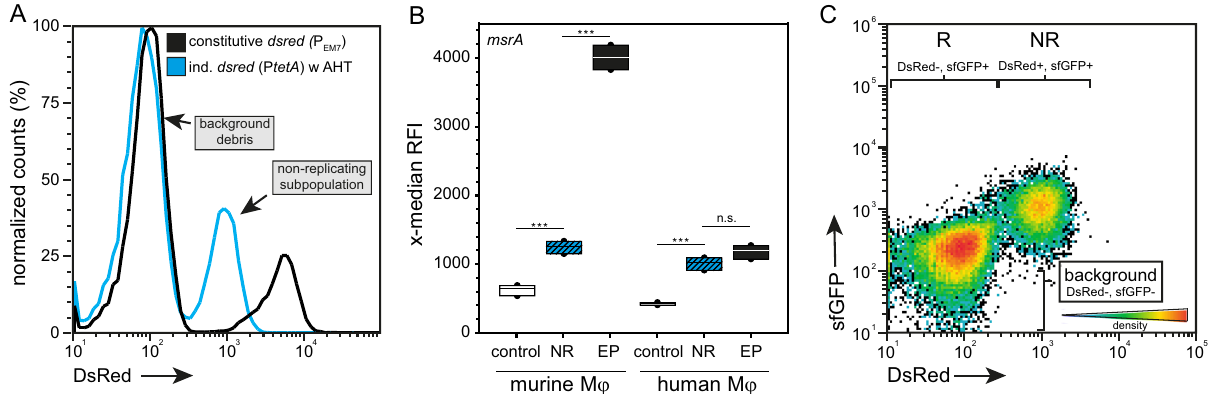
Fig. 6 Stress response of non-replicating STM WT in primary human macrophages. STM WT harboring AHT-inducible (NR) or constitutive (EP) dual- fl uorescence reporter for msrA was grown o/n in LB medium in the presence of AHT if necessary. Before infection, AHT was removed and murine RAW264.7 or human primary macrophages were infected. Host cells were lysed 24 h p.i., liberated STM were recovered, fi xed, and subjected to FC. As negative control, a dual FP reporter plasmid with sfgfp inactivated by a frameshift was used. A Detection of intracellular NR STM in human macrophages. B Comparison of msrA induction within murine and human macrophages. The x-median represents the msrA -induced sfGFP signal of DsRed-positive intracellular bacteria. Means and standard deviations of one representative experiment are shown. C STM WT only shows a NR subpopulation when plotting the bacterial population against their AHT-induced DsRed and msrA -induced sfGFP intensity. Statistical analysis was performed as described for Fig. 2.